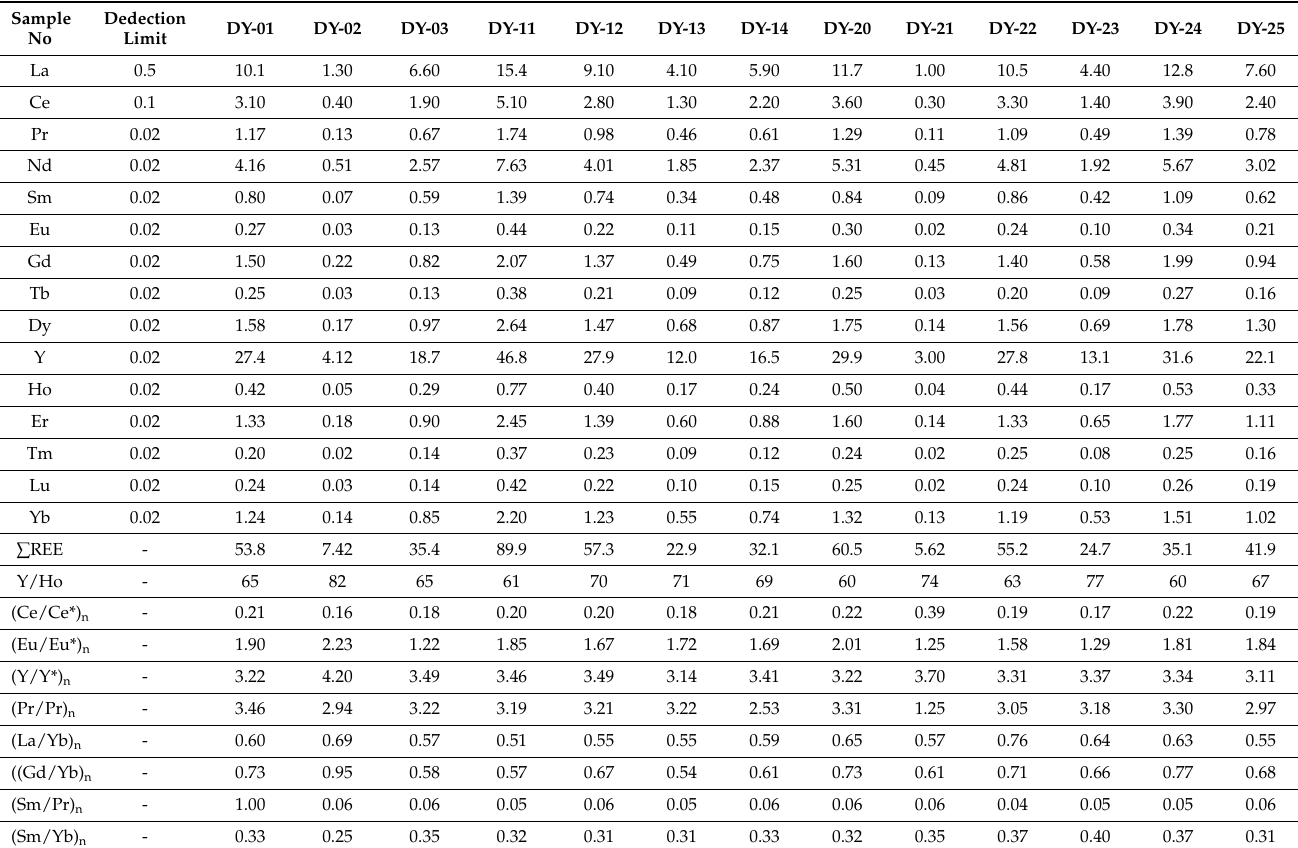
Table 5. Rare earth element contents of the phosphate samples